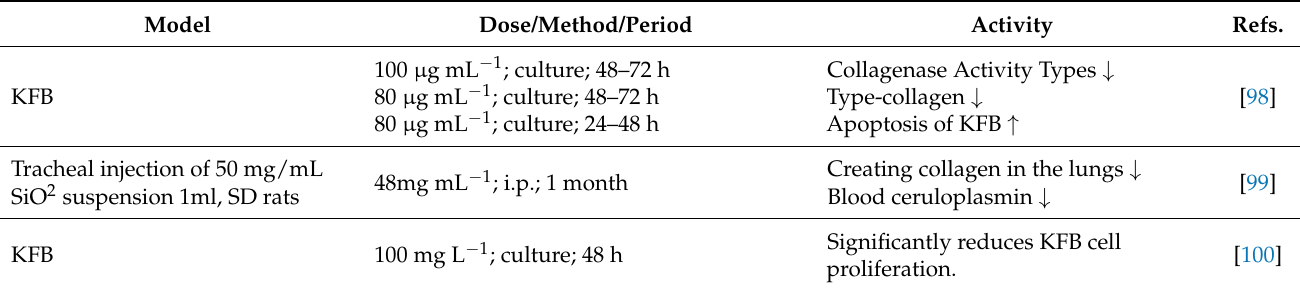
Table 1. Evidence for amygdalin’s anti-fibrosis effects: organized reviews and meta-analysis of the primary